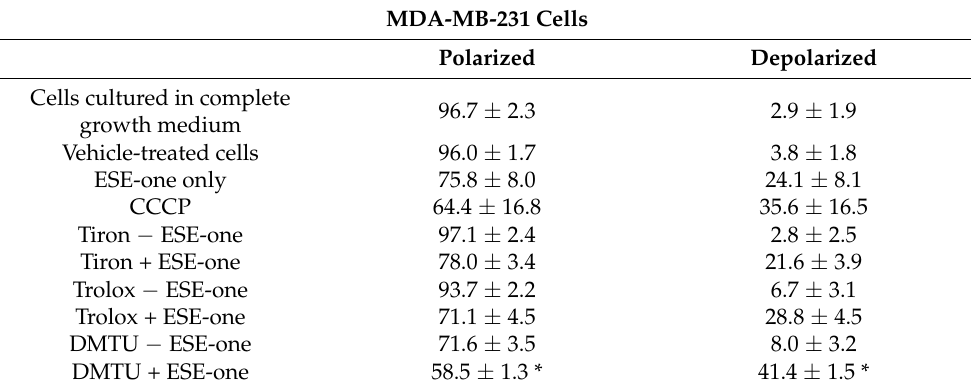
Figure 5. Mitochondrial membrane graphs of MDA-MB-231 cells exposed to ESE-one in the presence or absence of several scavengers of reactive oxygen species (tiron, trolox and DMTU). ESE-one only exposure resulted in depolarization of the mitochondrial membrane potential in MDA-MB-231 cells and tiron exposure resulted in an insignificant decrease in membrane depolarization. A represents polarized cells and B represents depolarized cells. Trolox and DMTU did not have an opposing effect on the membrane depolarization exerted by ESE-one (A indicates polarized population and B indicates depolarized population). ( a ) Cells cultured in complete growth medium, ( b ) vehicle-treated cells, ( c ) cells exposed to ESE-one, ( d ) cells exposed to carbonyl cyanide 3-chlorophenylhydrazone (CCCP), ( e ) cells exposed to tiron only, ( f ) cells coexposed to tiron and ESE-one, ( g ) cells exposed to trolox only, ( h ) cells coexposed to trolox and ESE-one, ( i ) cells exposed to DMTU only, ( j ) cells coexposed to DMTU and ESE-one. Table 5. Percentage of MCF-7 cell polarity of the mitochondrial membrane potential as determined by means of flow cytometry. An asterisk (*) indicates p -value ( p < 0.05) compared to ESE-one treated cells.